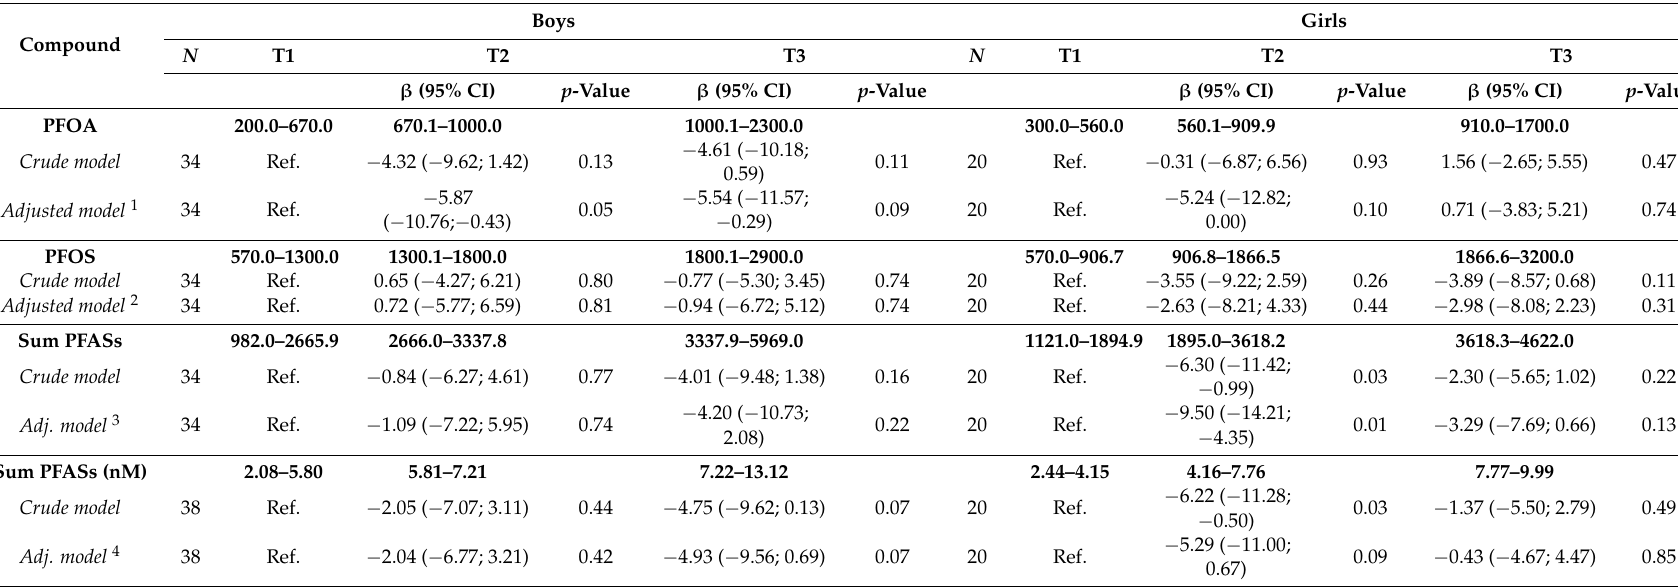
Table A4. Regression coefficients for exposure to perfluoroalkyl substances and scores on the Externalizing Behavior Scale of the CBCL, stratified for